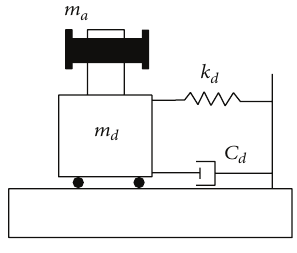
Figure 13: HMD system installed in 𝑛 th